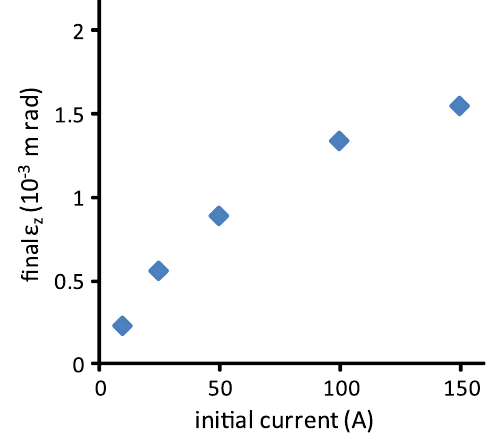
FIG. 11. Final z emittance at z ¼ 60 m ( (cid:1) 10 (cid:2) 3 ) vs initial peak